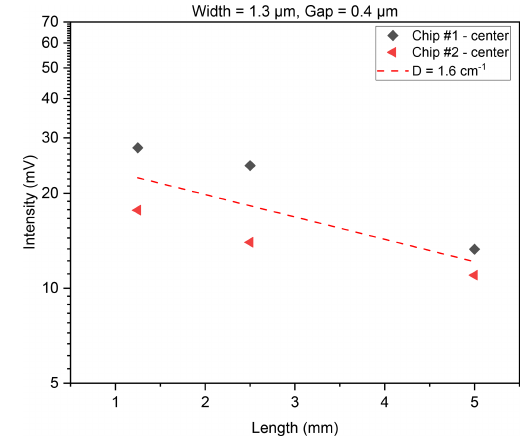
Figure 8. Determination of waveguide damping for protected waveguide structures taken from the wafer center. The linear fit re- veals a damping of the order of D center exp = 1 . 6cm − 1 (red dashed